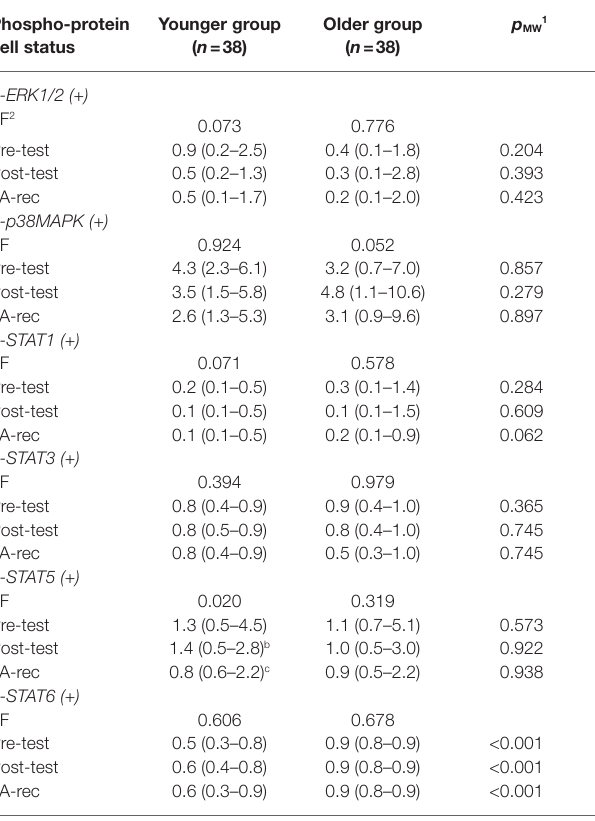
TABLE 5 | Percentage of T cytotoxic (CD8+) cells expressing (+) the analyzed phospho-proteins in peripheral blood of the participants. Phospho-protein Younger group cell status ( n = 38)